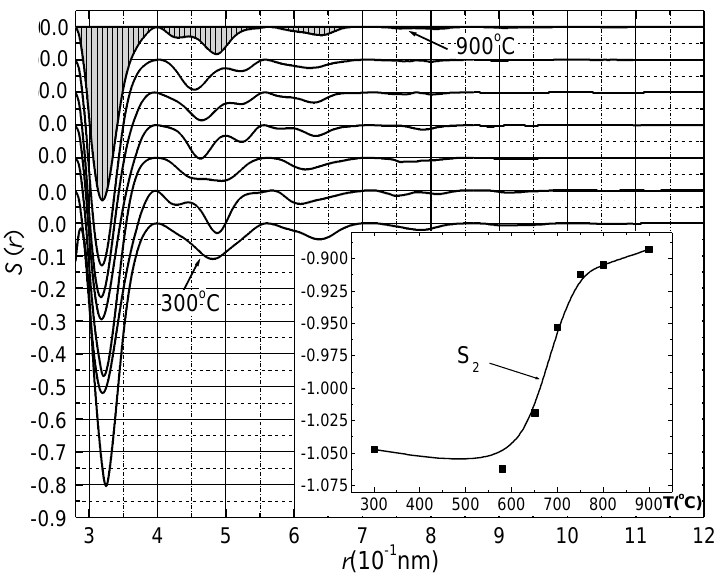
Figure 14. Patterns of the function S ( r ) curves for the melt In-Sn20 as well as the pair correlation entropy S 2 (Inset) at different temperatures